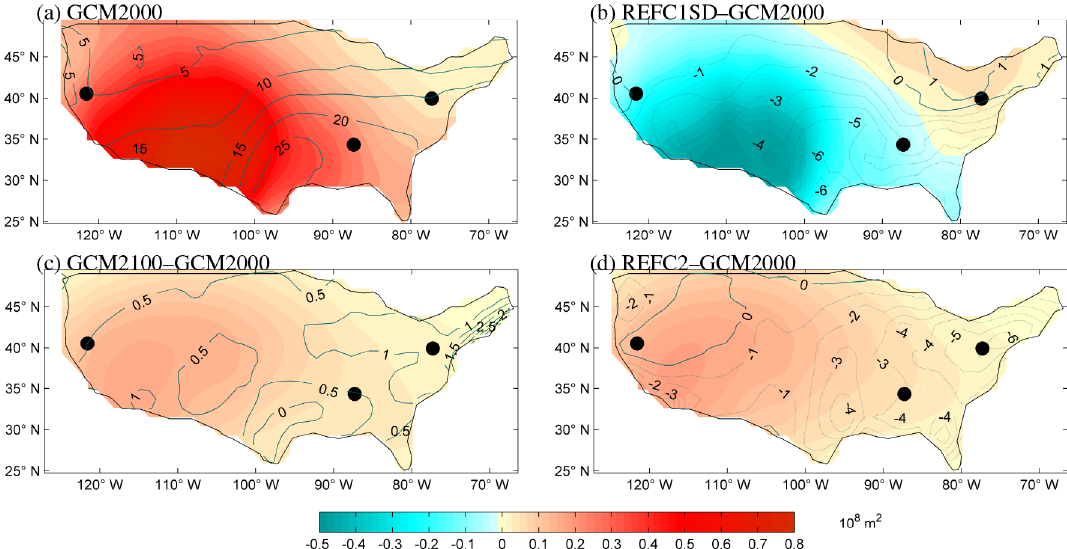
Figure 3. Wave activity (AWA: shaded using the legend in 10 8 m 2 ) and PM 2 . 5 concentrations (green contour lines in µgm − 3 ) for (a) the current climate (GCM2000, 2006–2025 summer days’ average); (b) reanalysis-driven case (REFC1SD, 1991–2010 summer days’ average) minus the current climate online case (GCM2000, 2006–2025 summer days’ average); (c) future climate with current emission (GCM2100, 2106–2125 summer days’ average) minus the current climate (GCM2000, 2006–2025 summer days’ average); (d) future climate with future emission (REFC2, 2080–2099 summer days’ average) minus current climate (GCM2000, 2006–2025 summer days’ average). Three black dots are representative stations (AREN1, SIPS1 and